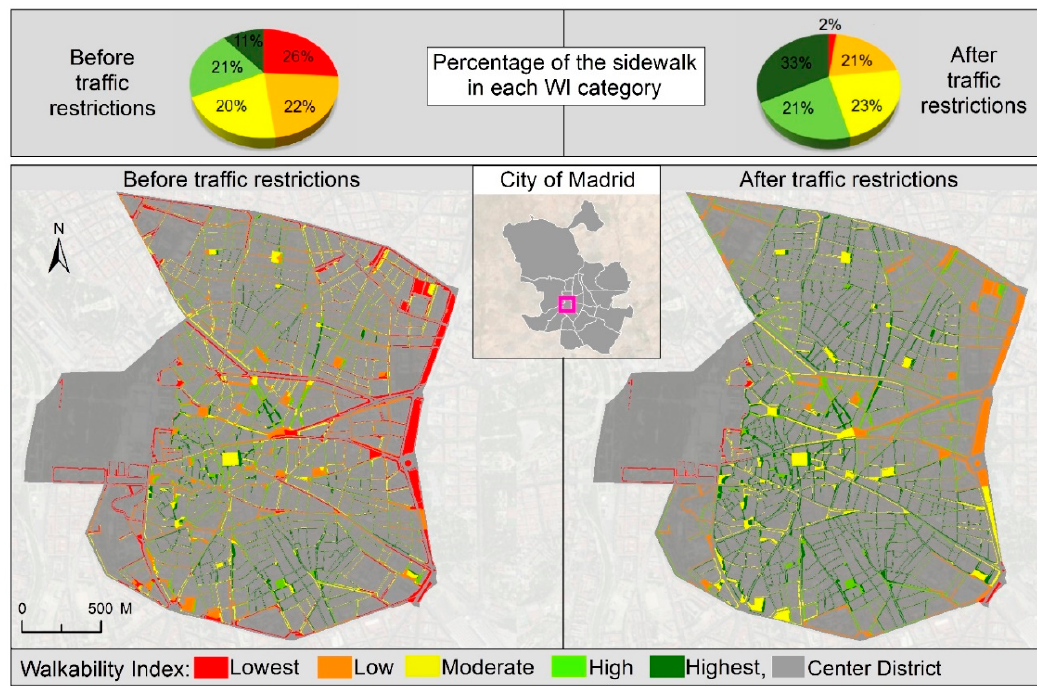
Figure 4. Effect of the noise factor over the proposed WI. Figure 4. E ff ect of the noise factor over the proposed